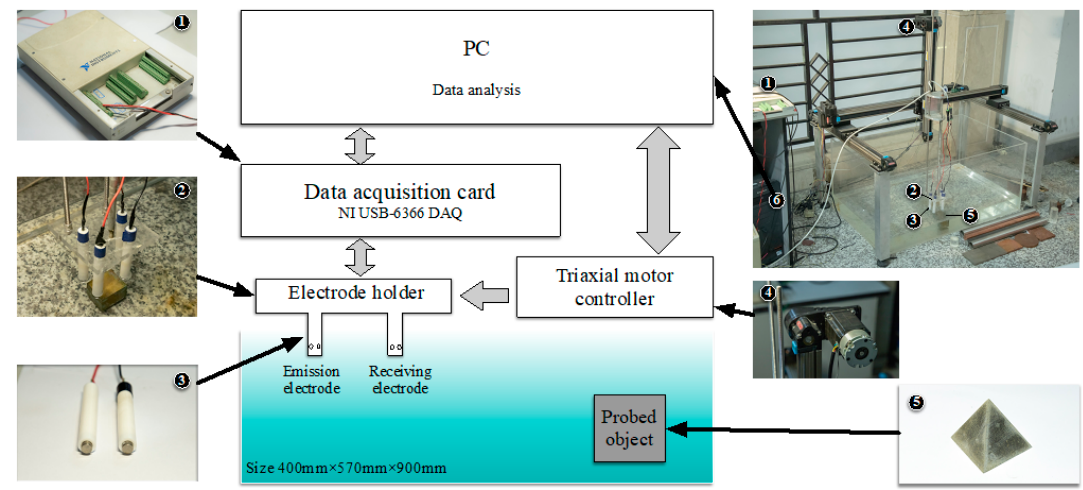
Figure 3. Experimental platform framework of underwater active electrolocation